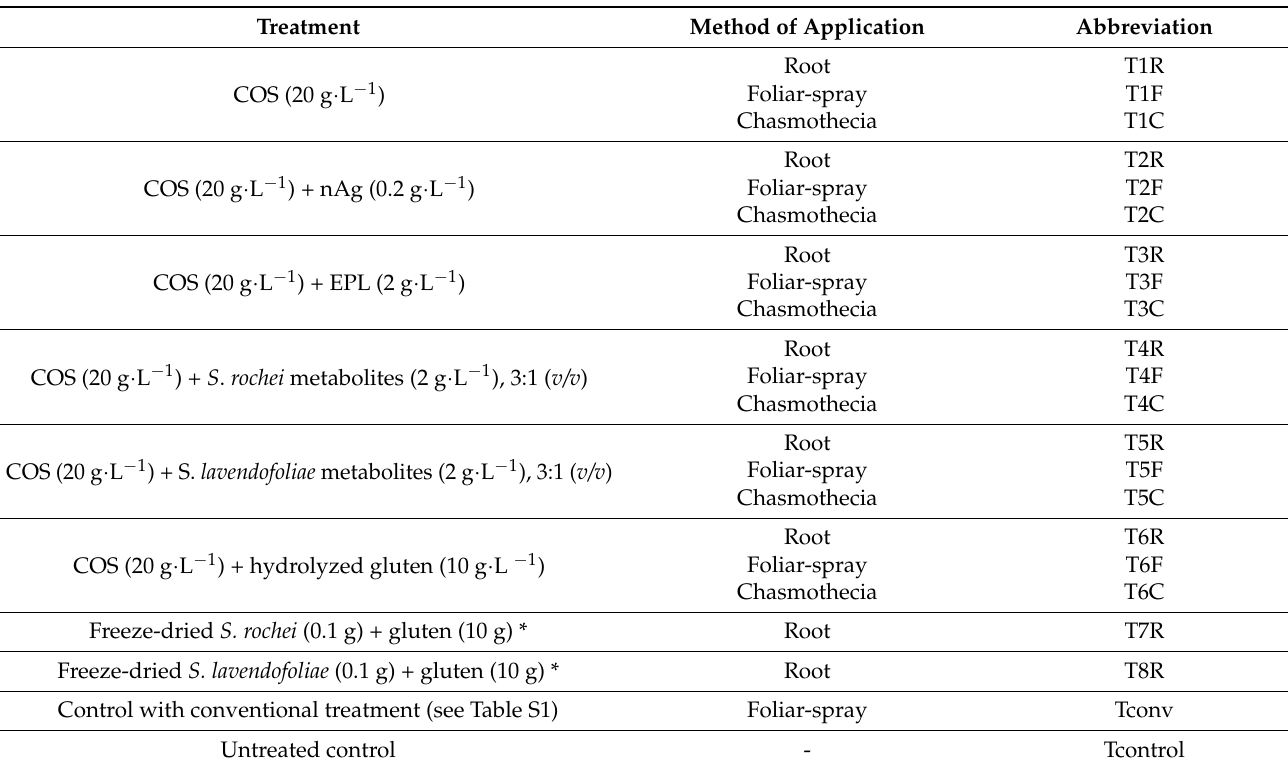
Table 1. Summary of treatments used against powdery mildew in the field and in vitro against